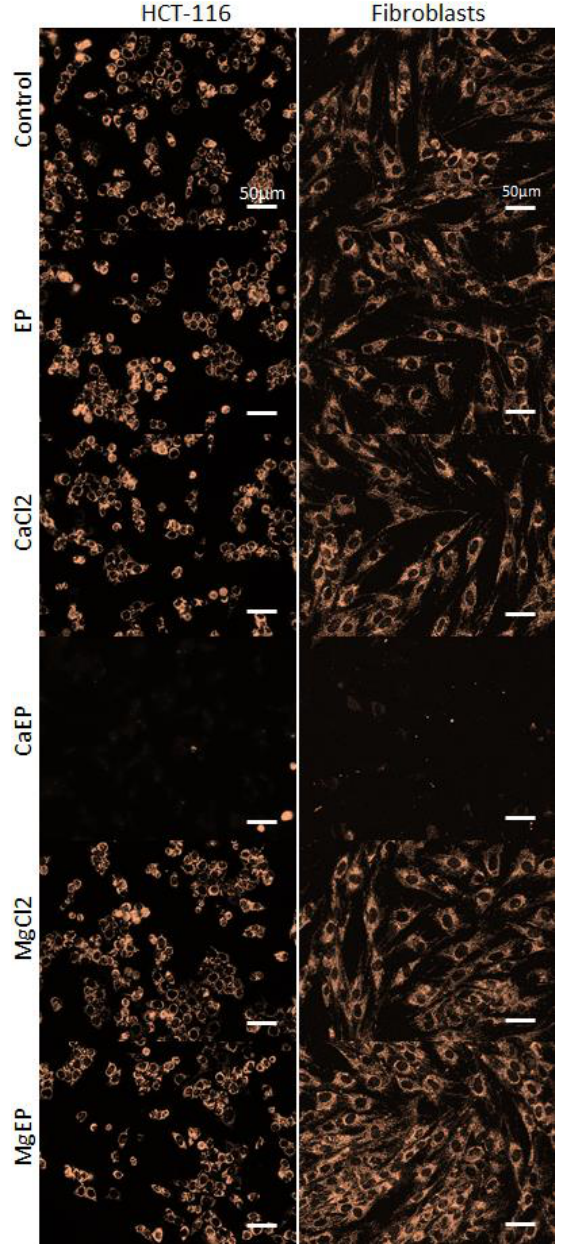
Figure 6. Drastic mitochondrial membrane potential alteration 5 min after electroporation associated with 5 mM calcium. Mitochondrial membrane potential was observed thanks to MitoView633 fluorescent probe in HCT-116 cells and dermal fibroblasts. Representative pictures of two independent experiments.